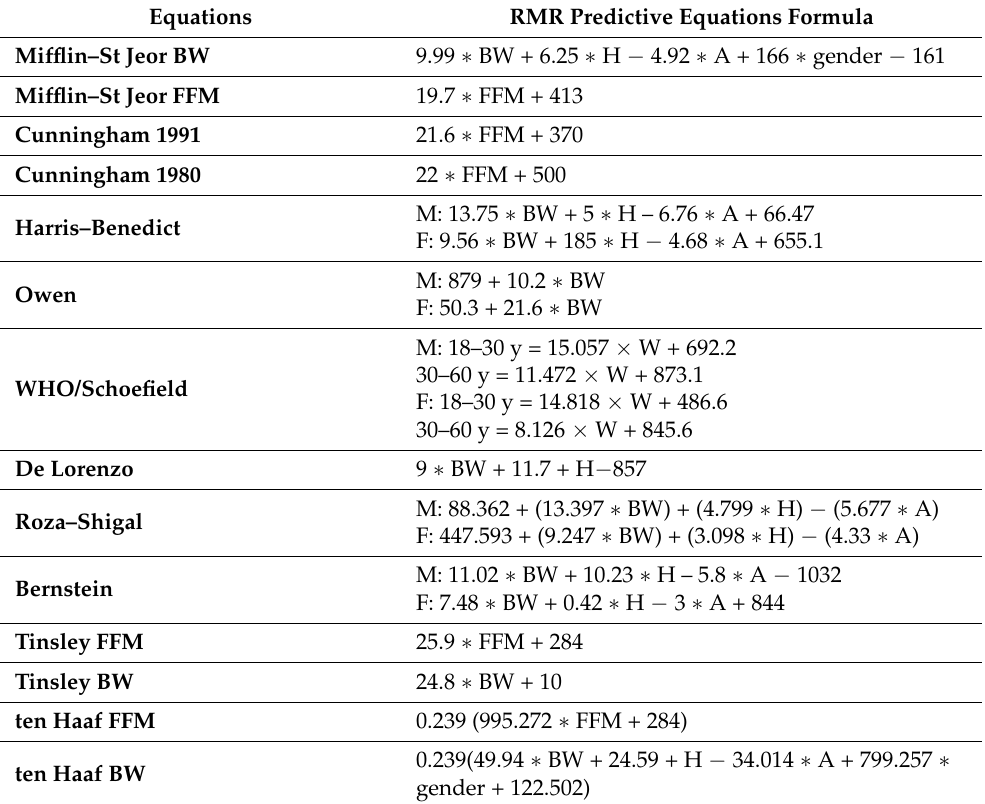
Table 1. Resting metabolic rate (RMR) (kcal/day) equations considered in the study. Equations RMR Predictive Equations